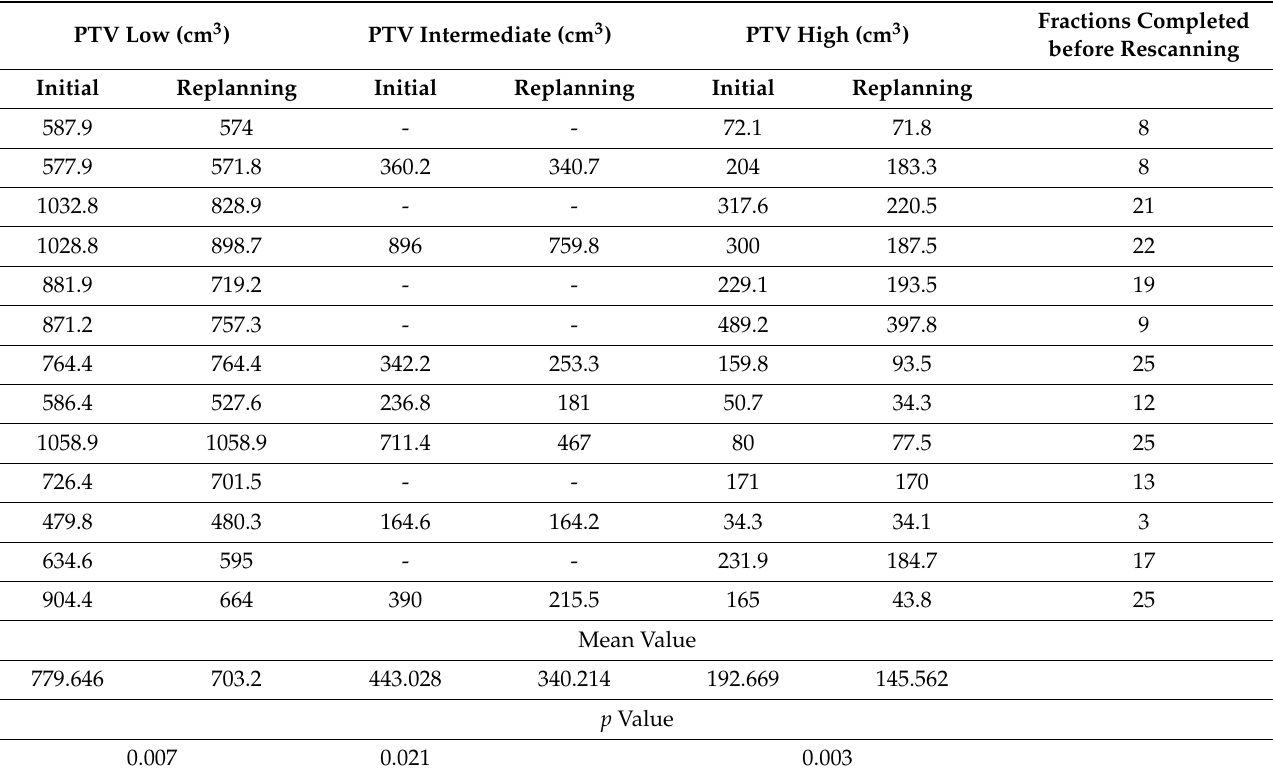
Table 3. The size of the PTVs at the first and second scan.